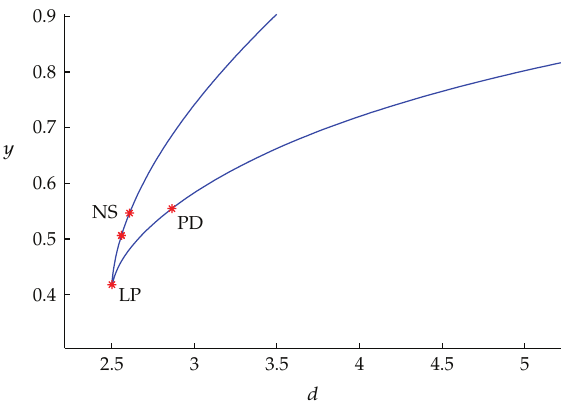
Figure 9: Curve of fixed points of the fourth iterate starting from the 4-cycle C 4 .